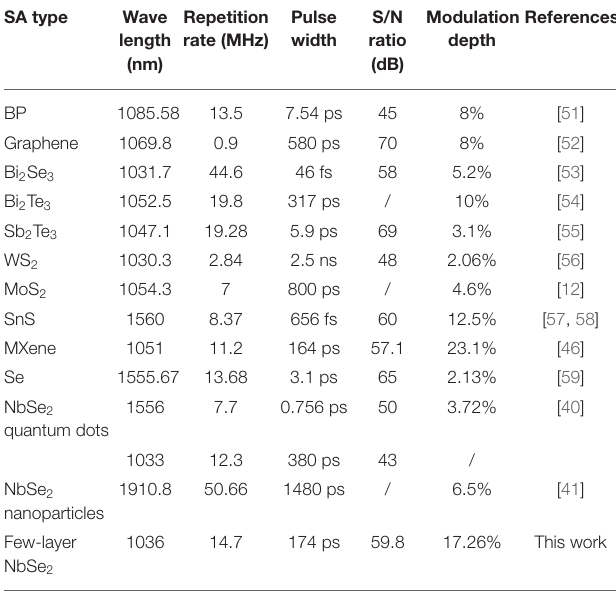
TABLE 1 | Ultrafast mode-locked fiber laser performance for low-dimensional materials. SA